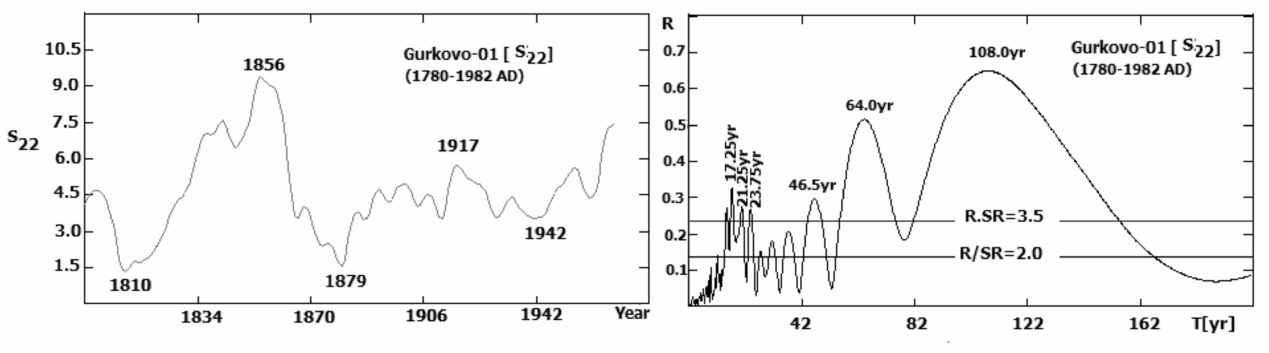
Figure 6. Left : The amplitude index S22 of “Gurkovo-01” beech sample Dm-series. The moving window width is equal to 30 years; right : the corresponding T – R